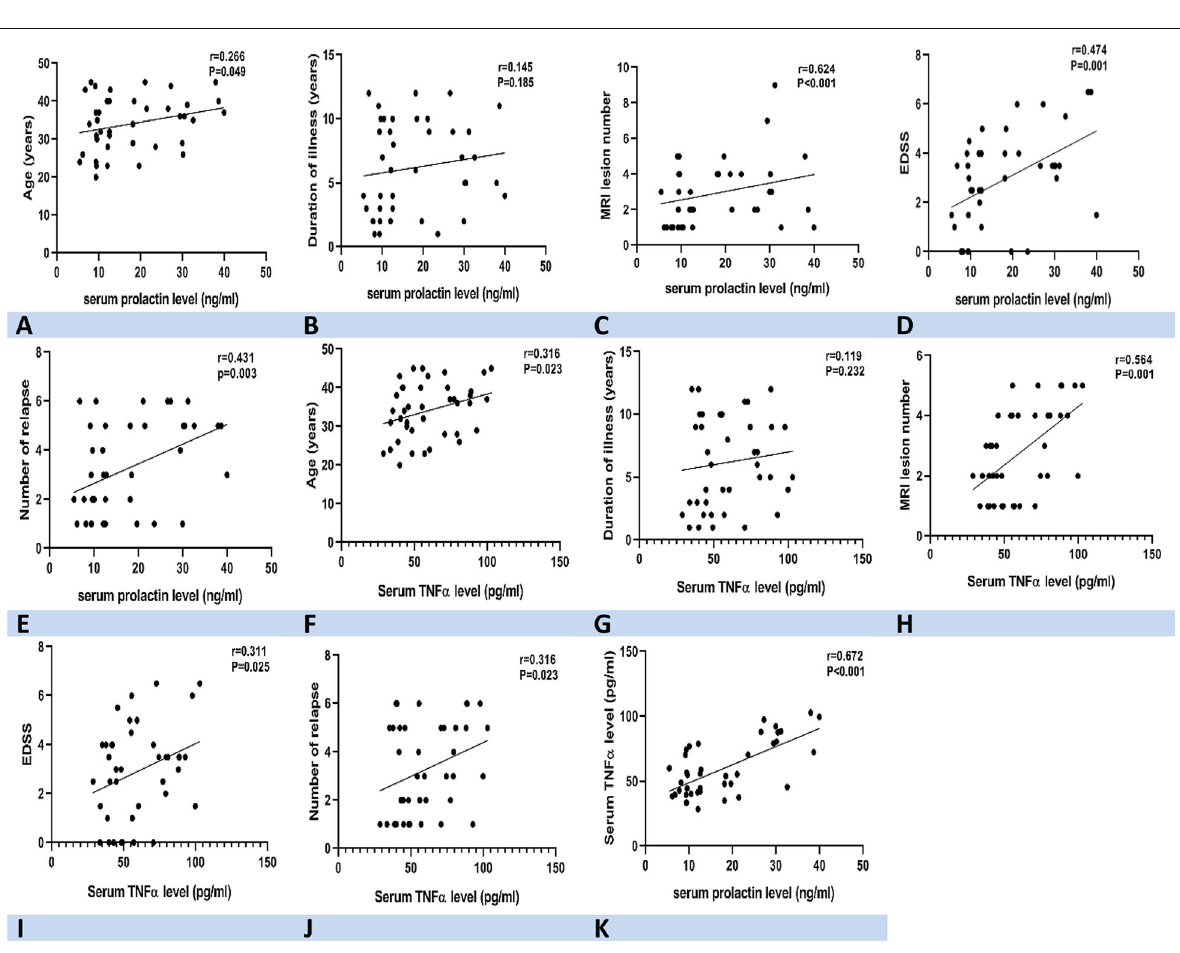
Fig. 4 Correlation of serum PRL in MS patients in relapse with a age, b duration of illness, c MRI lesion number, d EDSS, and e number of relapse. Correlation of serum TNF α in MS patients in relapse with f age, g duration of illness, h MRI lesion number, i EDSS, and j number of relapse. k Correlation of serum PRL with serum TNF α in MS patients in